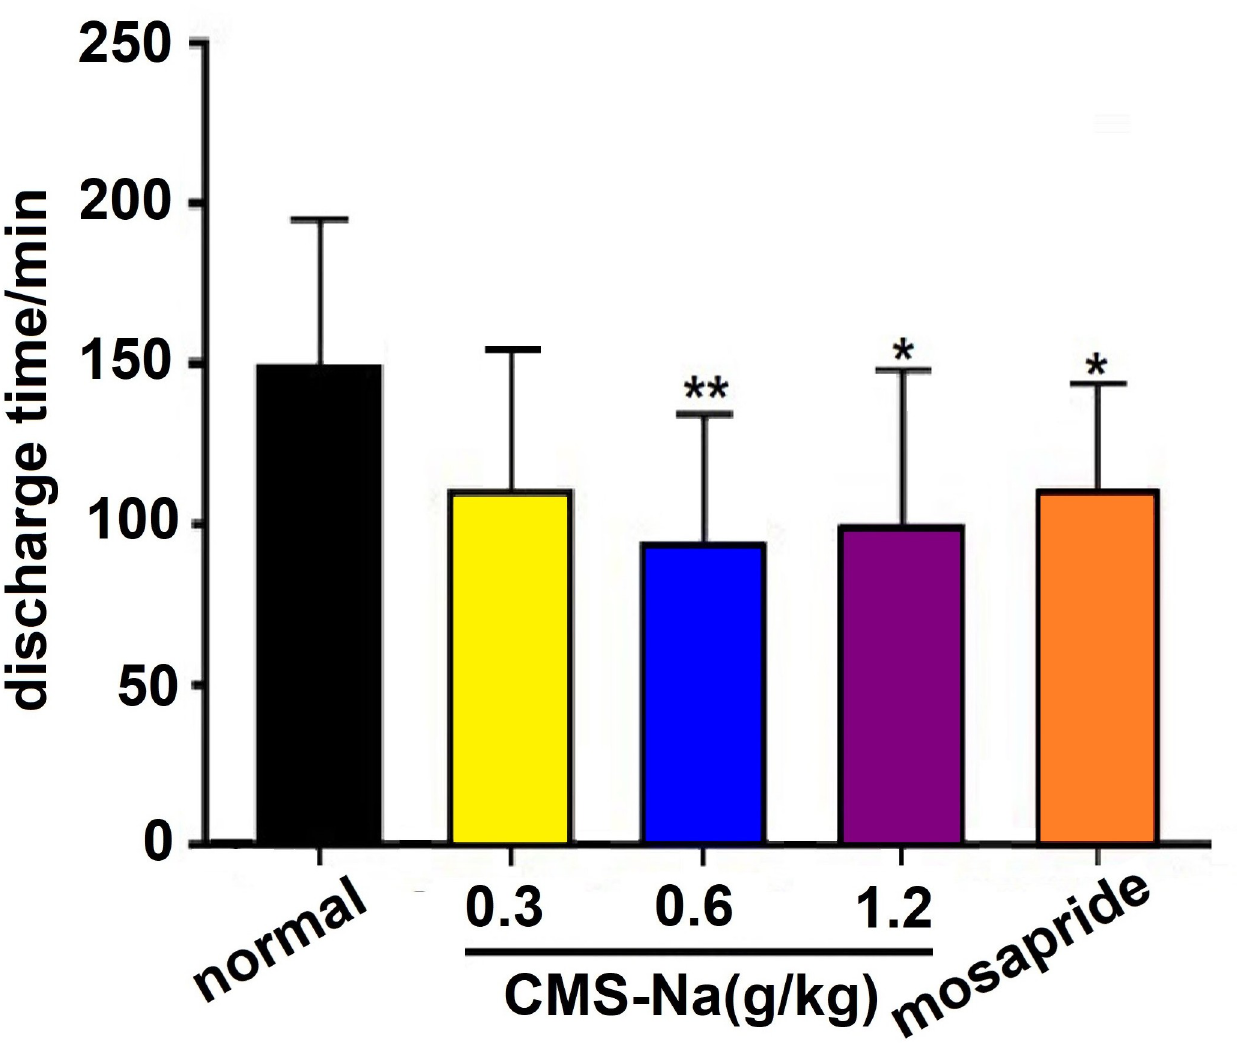
Fig 3. Effect of CMS-Na on colonic transit in normal rats. Rats were orally treated with 0.3, 0.6, or 1.2 g � kg -1 CMS-Na or 1.2 mg � kg -1 mosapride once a day for 7 d. Then, 3.5 mm glass beads were inserted into the junction of the rectum and the colon in rats and the discharge time was recorded. Mean ± SD, n = 10, � P < 0.05, �� P < 0.01, vs.